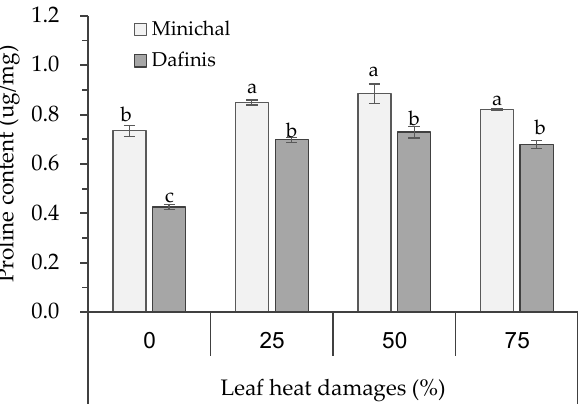
Figure 8. Total proline content as affected by different leaf heat damages in tomato cultivars grown